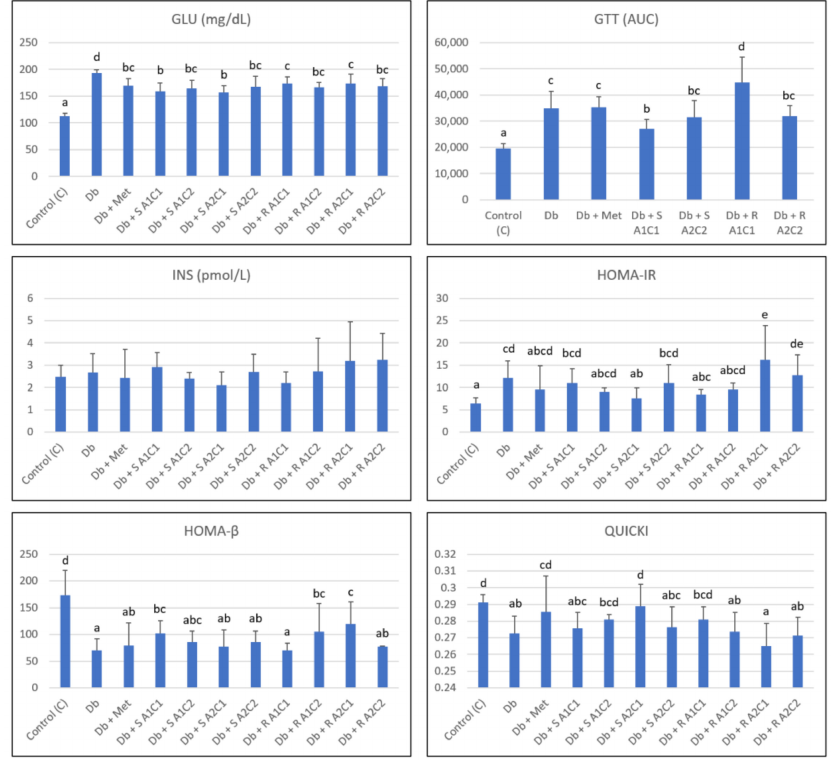
Figure 1. Effects of the diet and combined SG, L-arg, and Cr(III) supplementation on glucose-related indices in rats. GLU: glucose, GTT: glucose tolerance test, INS: insulin, HOMA-IR: insulin resistance index, HOMA- β : β -cell function index, QUICKI: quantitative insulin sensitivity check index. Data are presented as the mean ± standard deviation (M ± SD). Mean values with different letters (a–e)